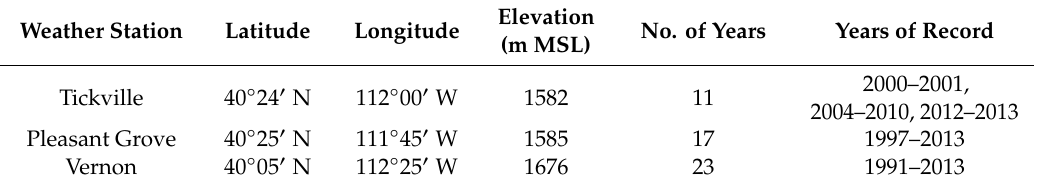
Table 2. Characteristics of remote automated weather stations selected for analysis and available years of